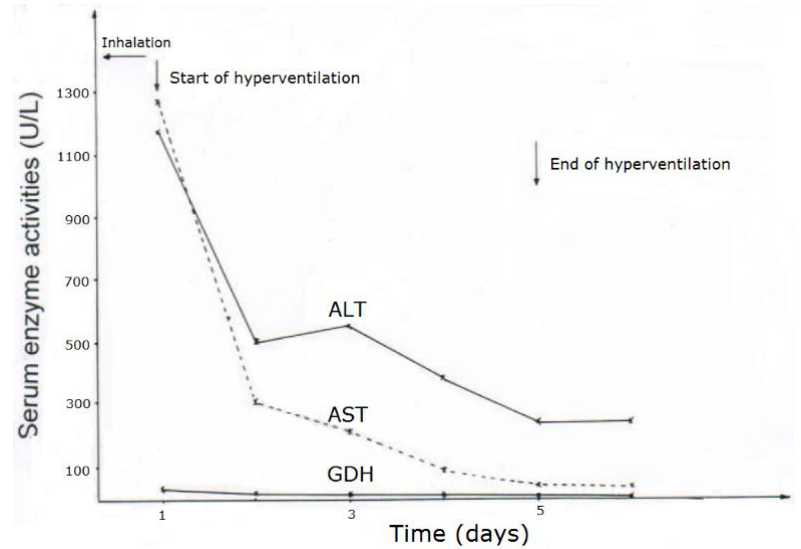
Figure 1. Patient 11 intoxicated by inhalation of CCl 4 (unknown amounts), presenting serum activities of ALT, AST, and GDH under CO 2 -induced hyperventilation therapy. Abbreviations: ALT, Alanine aminotransferase; AST, Aspartate aminotransferase; GDH, Glutamate dehydrogenase.